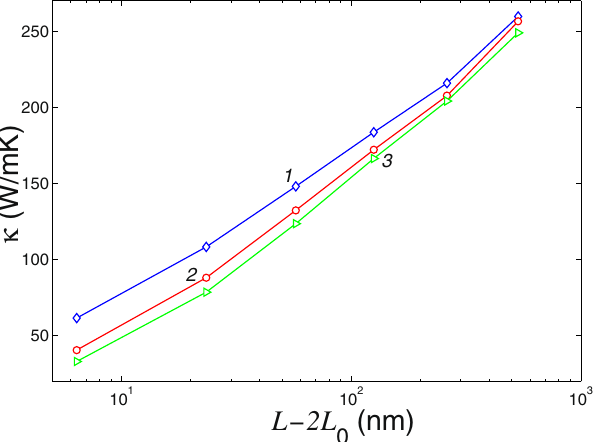
Figure 10. Coefficient of thermal conductivity κ vs. the length of the central part of the nanoribbon L − 2 L 0 for an ideal nanoribbon (curve 1), for a nanoribbon with a double vacancy V 2 (585) and a transverse array of the inverse Stone-Wales defects (curves 2 and 3). Nanoribbon width is D = 1.72 nm, temperature T = 300 K , L 0 = aN 0 is the length of the nanoribbon ends interacting with